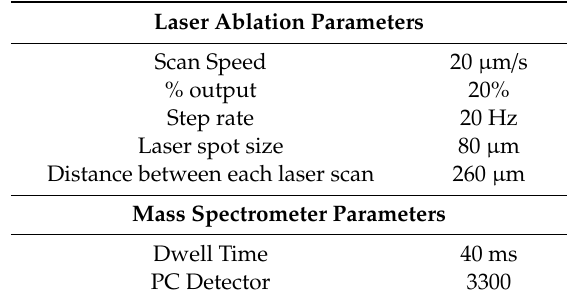
Table 1. List of instrumental parameters for the laser ablation (LA)-ICP-MS experiments.